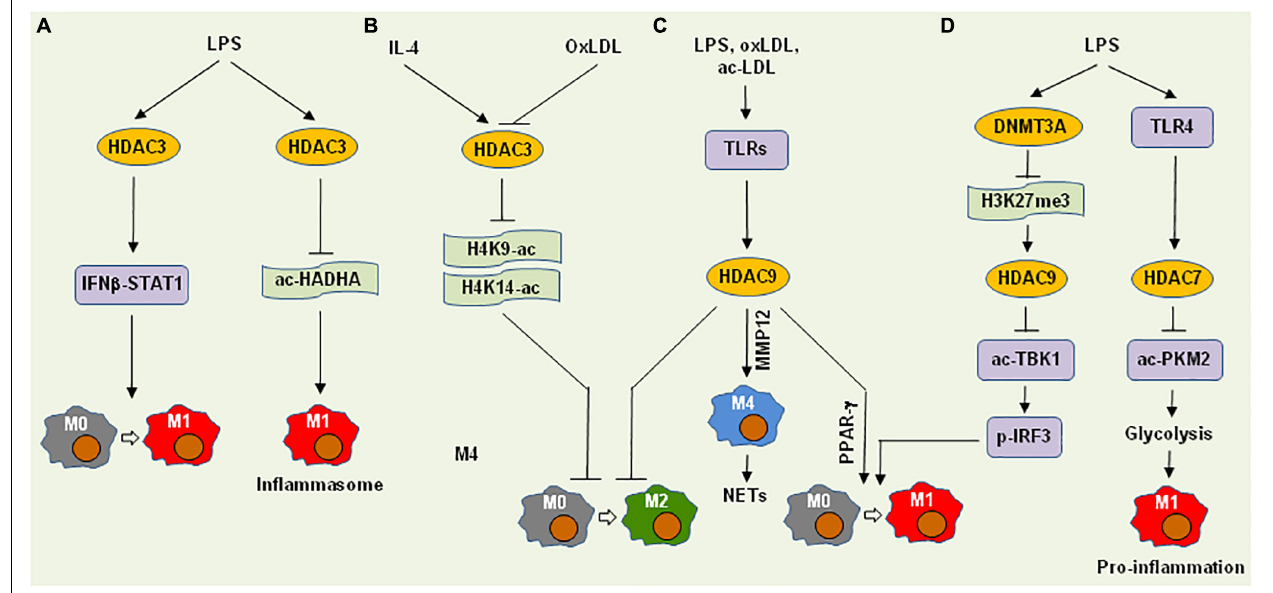
FIGURE 3 | Histone deacetylases promote M1 polarization and pro-inflammatory functions of macrophages via deacetylation of histones or non-histone proteins. (A) HDAC3 mediates LPS-induced M1 polarization and inflammasome activation via the IFN β -STAT1 signaling cascade and HADHA deacetylation that restricts fatty acid oxidation, respectively. (B) On the other hand, HDAC3 can block M2 polarization involving either IL-4 or oxLDL via deacetylation of H4K9-ac and H4K14-ac. (C) Multiple pro-inflammatory factors (e.g., LPS, oxLDL, and ac-LDL) induce the expression of HDAC9 via toll-like receptors (TLR), which in turn inhibits M2 polarization, promotes M1 polarization via PPAR γ , or induces M4 macrophages (in conjunction with MMP12) that recruit neutrophils to form neutrophil extracellular traps (NETs). (D) LPS induces HDAC9 expression via DNMT3A-associated repression of H3K27me3, thus triggering M1 polarization via deacetylation of TBK1 that phosphorylates IRF3. Alternatively, LPS up-regulates HDAC7 via TLR4, which deacetylates PKM2 to promote glycolysis, thereby promoting pro-inflammatory function of M1 macrophages. HDAC, histone deacetylase; IFN β , interferon β ; STAT1, signal transducer and activator of transcription 1; HADHA, hydroxyacyl-CoA dehydrogenase trifunctional multienzyme complex subunit alpha; oxLDL, oxidized low-density lipoprotein; ac-LDL, acetylated low-density lipoprotein; MMP12, matrix metallopeptidase 12; PPAR γ , peroxisome proliferator-activated receptor gamma; DNMT3A, DNA methyltransferase 3A; TBK1, TANK-binding kinase 1; PKM2, pyruvate kinase muscle isozyme 2; ac-, acetylation; p-,